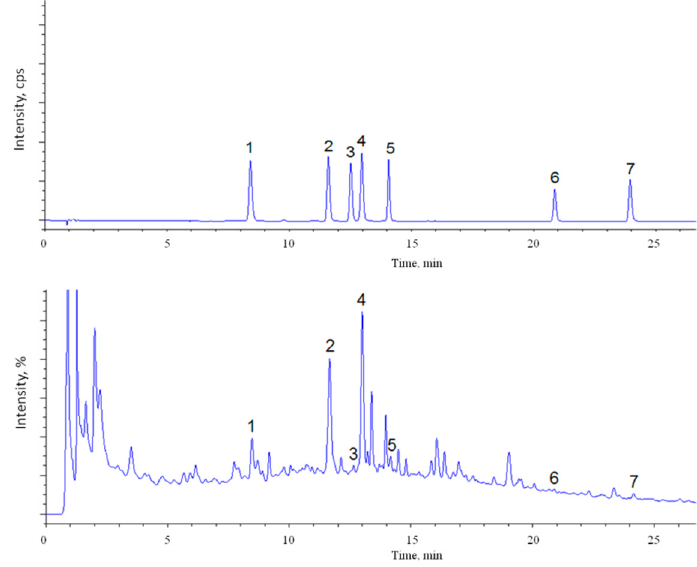
Figure 1. Total Ion Chromatogram (TIC) ( top ) and UV ( bottom ) at 280 nm of purslane leaves extract. The numbers correspond to the identified peaks: (1) caffeic acid; (2) p -coumaric acid; (3) scopoletin; (4) ferulic acid; (5) quercetin-3- O -rhamnoside; (6) quercetin; and (7) apigenin.